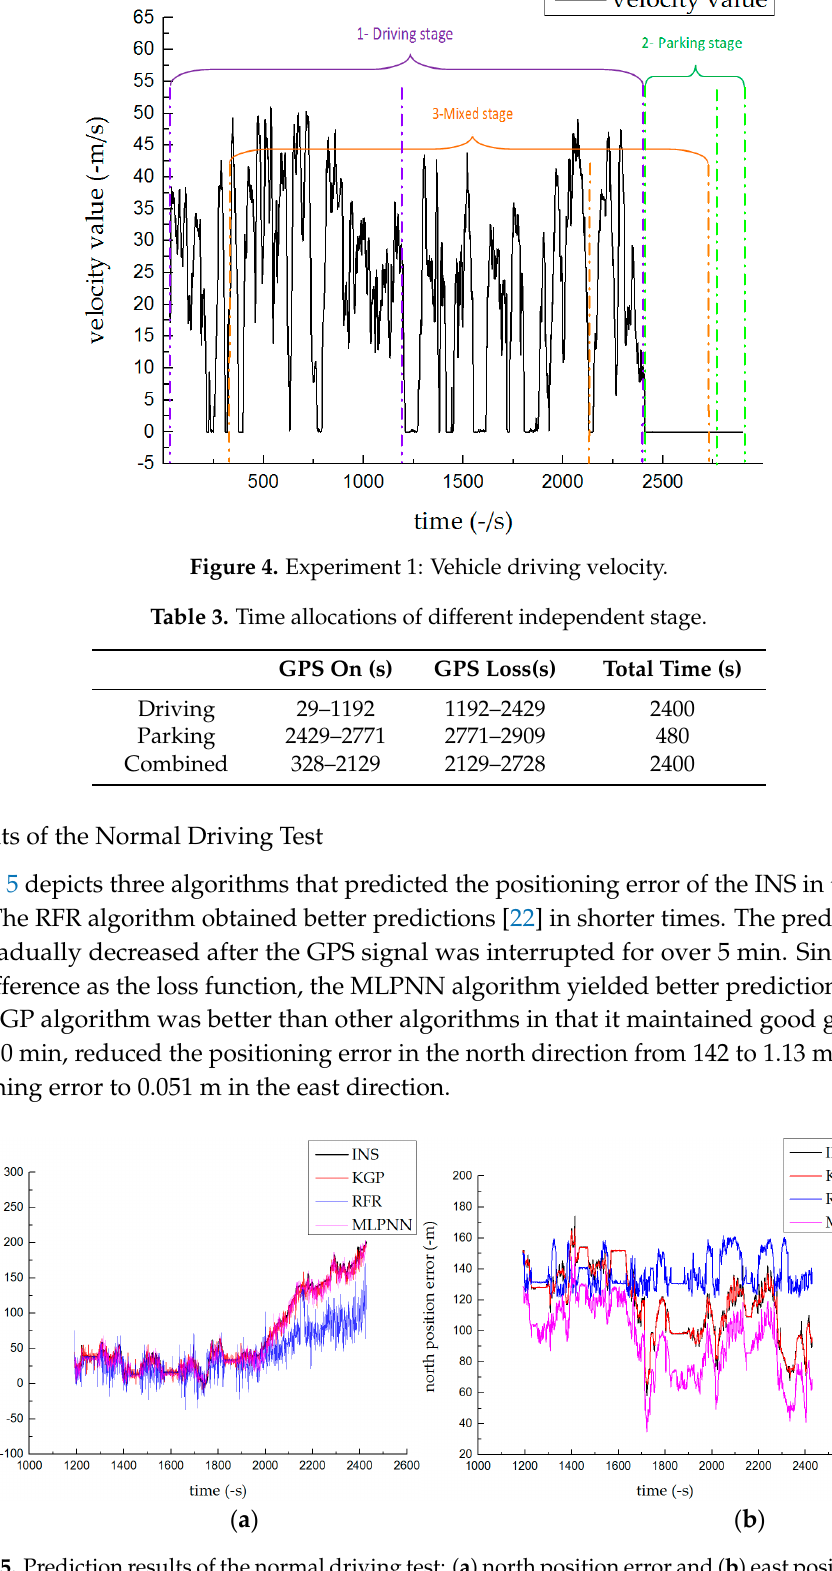
Figure 5. Prediction results of the normal driving test: ( a ) north position error and ( b ) east position error.